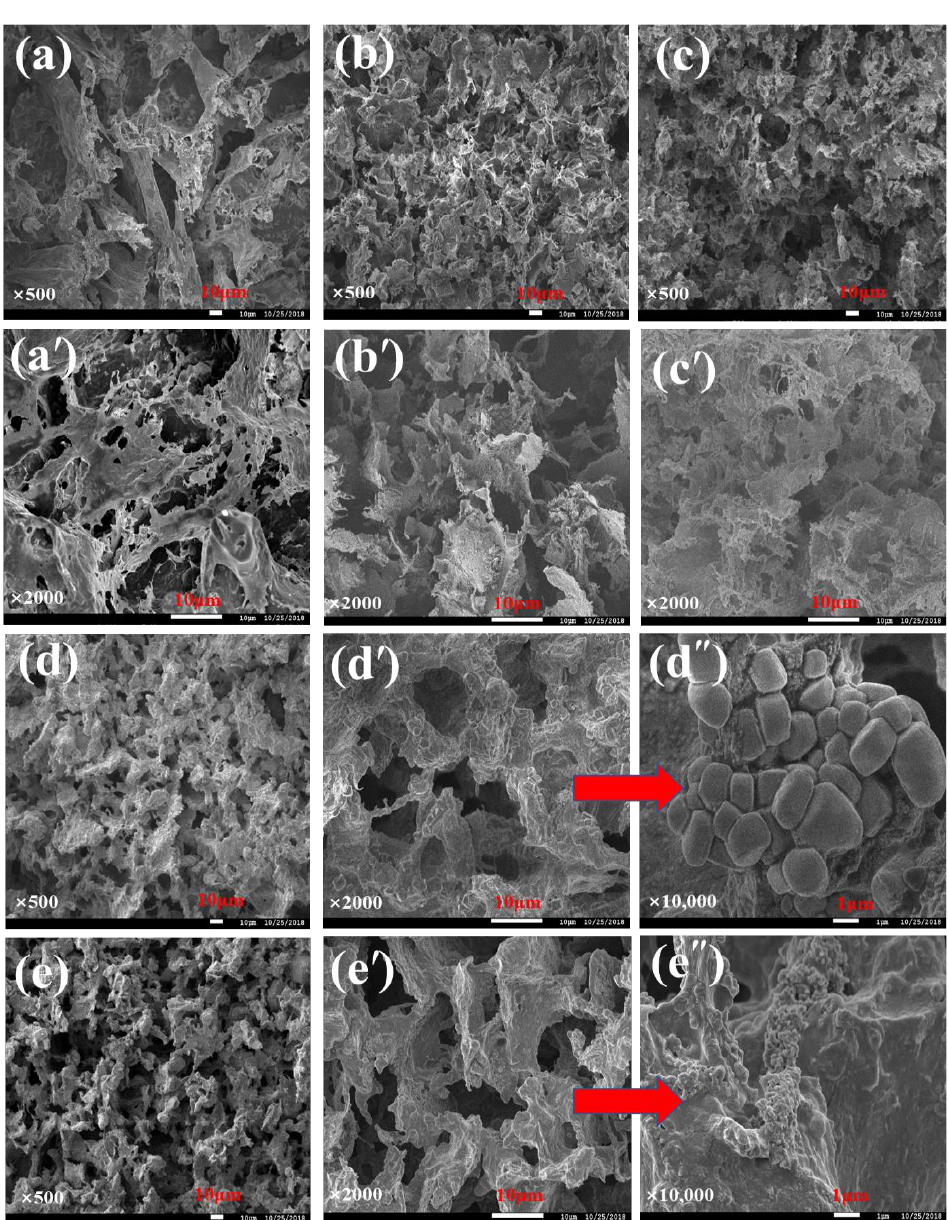
Figure 1. SEM images of the different PAM composite aerogels. ( a , a′ ) PAM, ( b , b′ ) PAM/Ms, ( c , c′ ), PAM/K, ( d , d′ , d ″ ) PAM/MsCa, ( e , e′ , e ″ ) PAM/KCa. PAM/K, ( d , d (cid:48) , d (cid:48)(cid:48) ) PAM/MsCa, ( e , e (cid:48) , e (cid:48)(cid:48) )